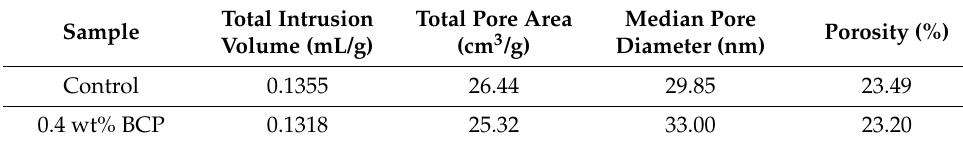
Table 2. Basic parameters of pore structure estimated from MIP